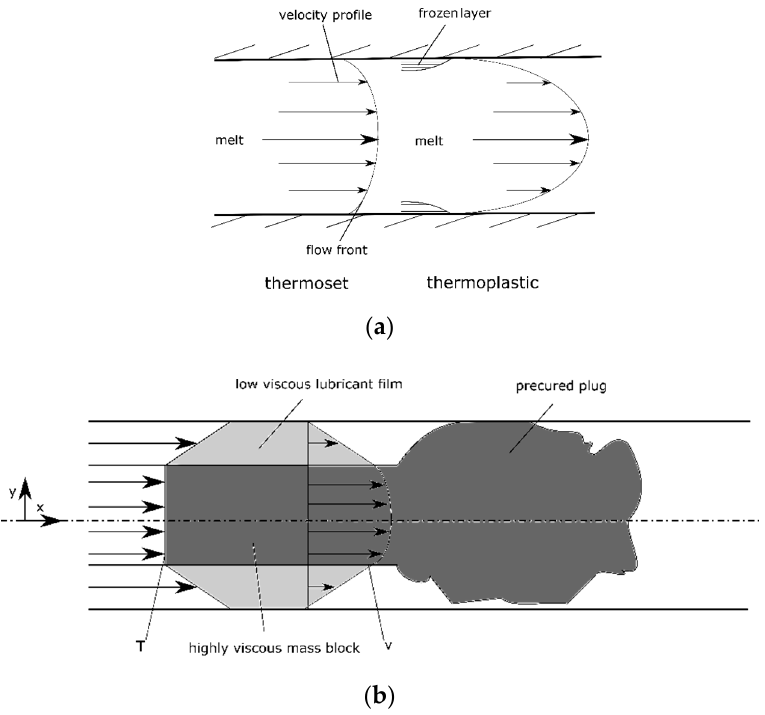
Figure 1. ( a ) Comparison of flow profiles of thermoset and thermoplastic injection molding. ( b ) Detail of flow profile of thermoset injection molding according to the model of block-shear flow. Highly viscous melt remains at the flow front and within the core while a low viscous sliding zone without fillers is formed at the surface. The surface texture is reproduced very detailed by the low viscous resin. Within the mass block, fillers and additives are contained. The undefined precured plug needs to be removed prior to entering the mold.